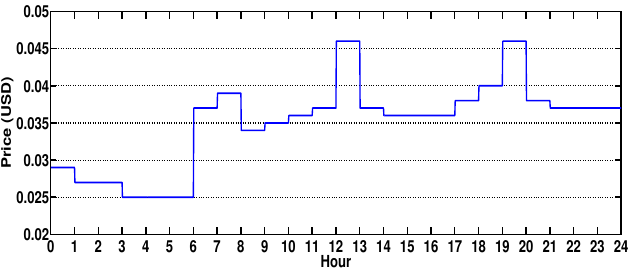
Figure 5. An example of real-time electricity